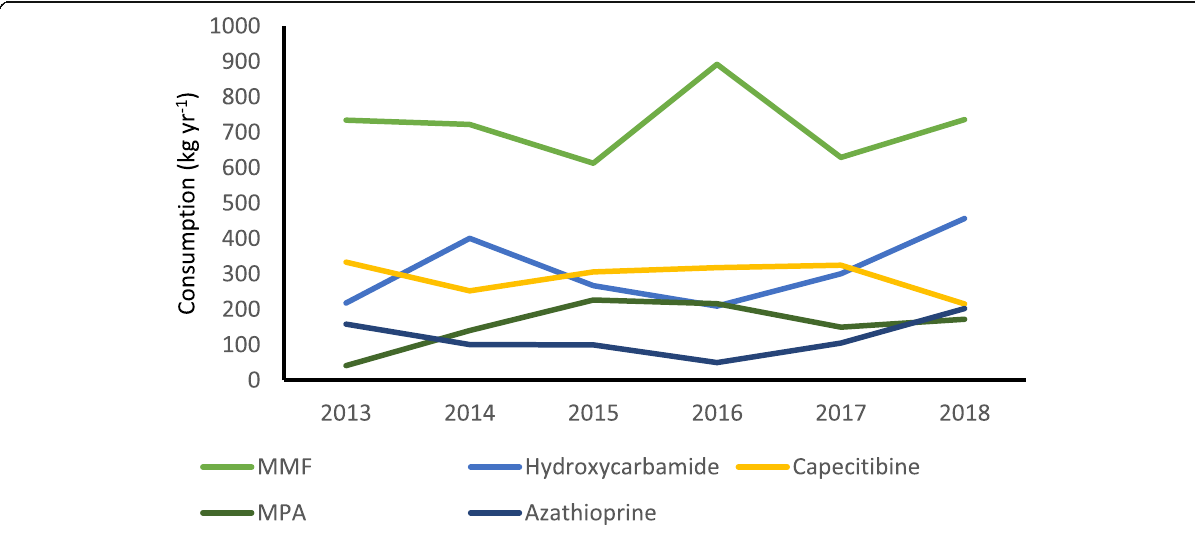
Fig. 4 Trend in the consumption of commonly prescribed chemotherapeutic drugs (2013 –